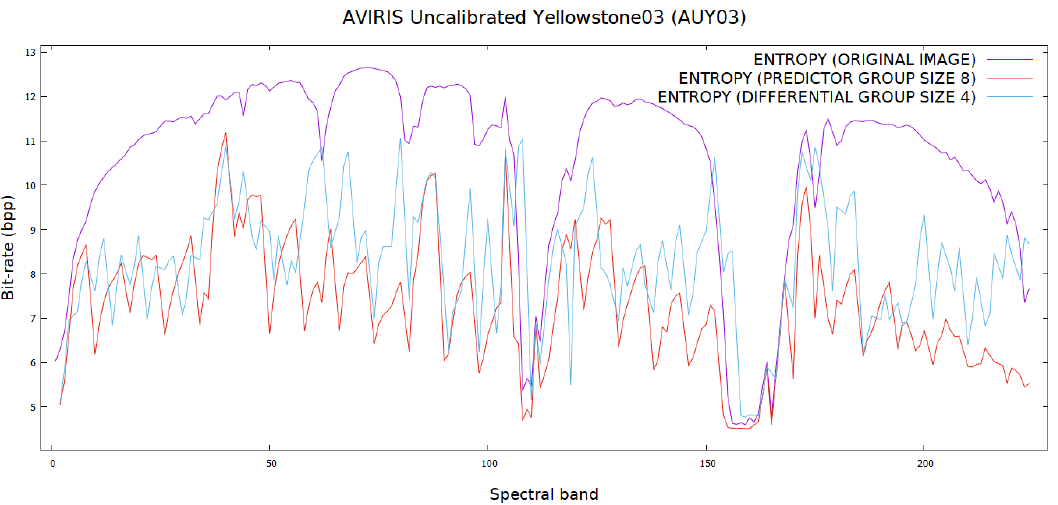
Figure 14. An entropy comparison of Yellowstone03 using differential and predictive methods. Data for reference bands are not included.